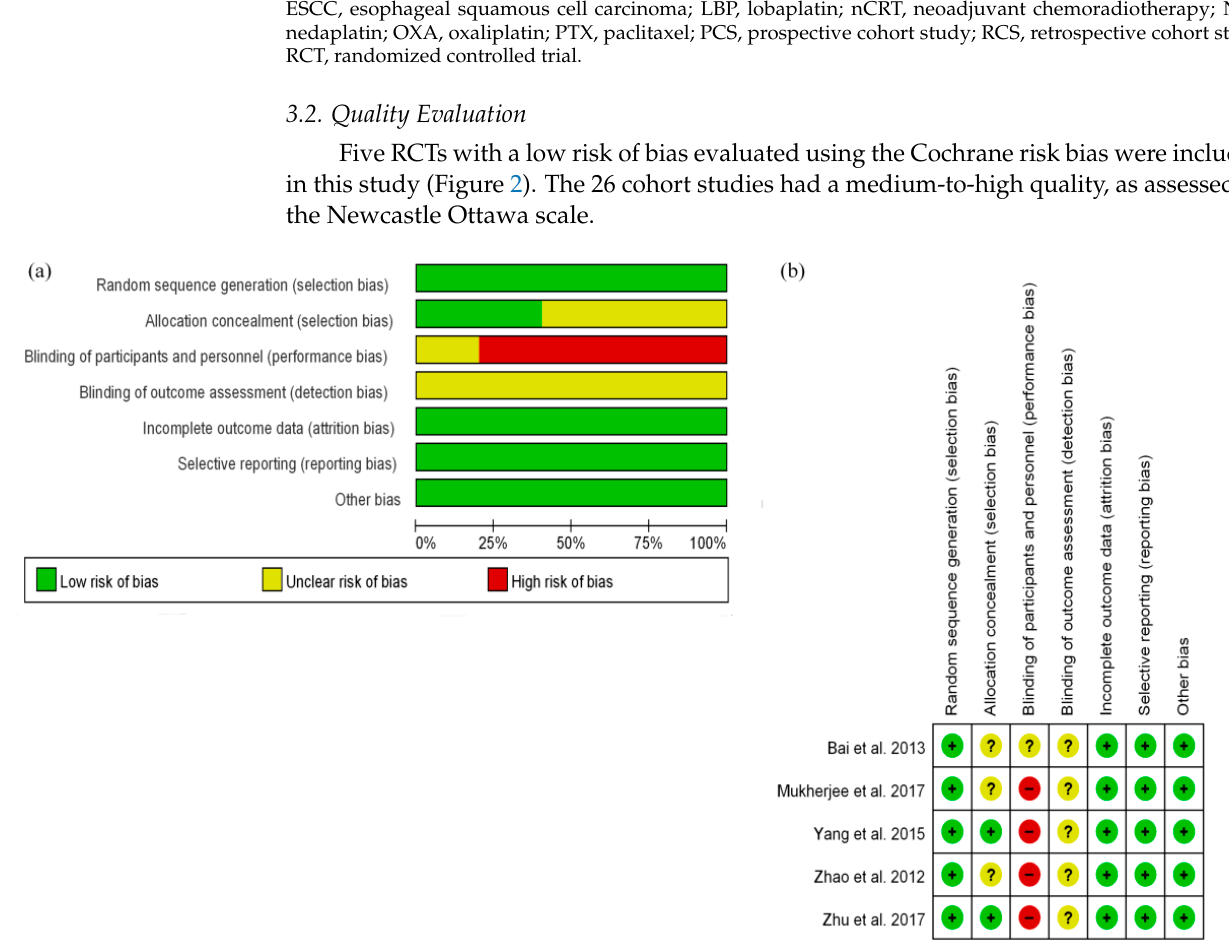
Figure 2. The Cochrane risk bias of five randomized controlled trials. ( a ) risk of bias graph; ( b ) risk of bias summary.